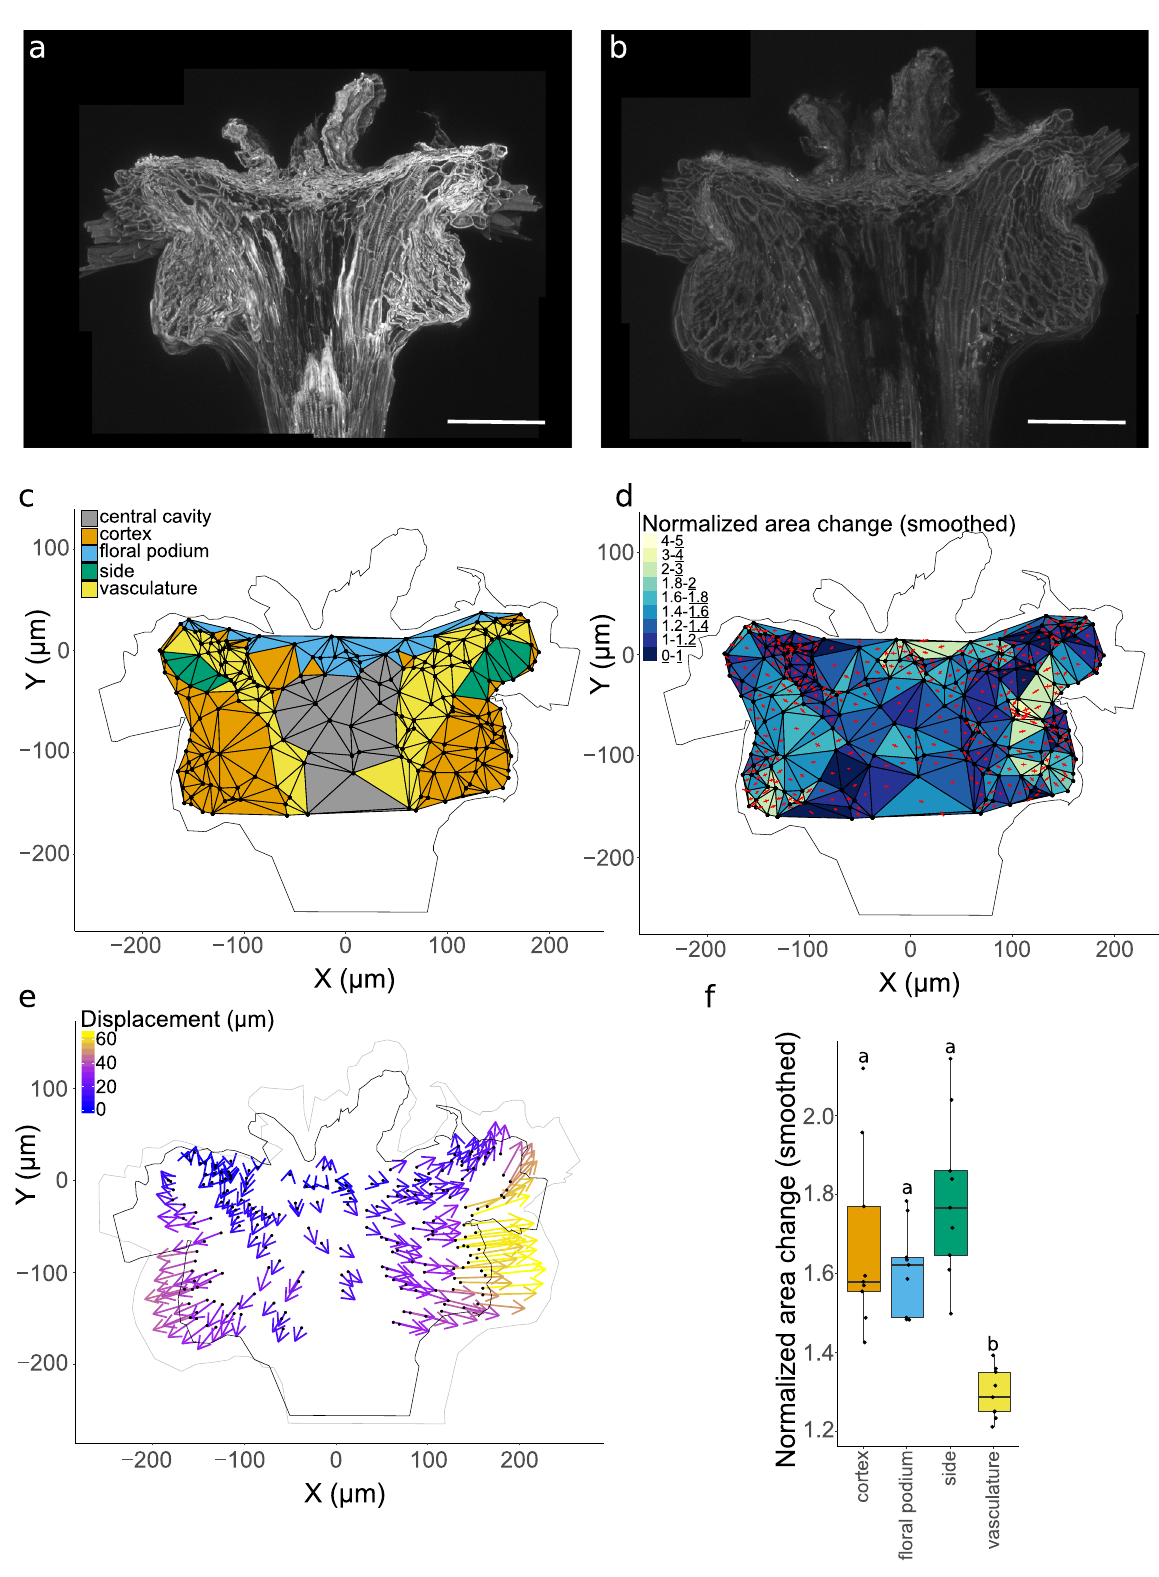
Fig. 4 Apical plate regional expansion and displacement. a , b Confocal images of apical plate auto fl uorescence in dry, a , and hydrated, b states, scale bars are 100 μ m, and images are representative of n = 9 biologically independent samples. c Landmarks and triangulation with regions annotated. d Smoothed change in area of each triangle (wet area/dry area). Red crosses indicate principal directions of expansion. e Displacement of landmarks relative to upper central part of the apical plate. f Change in area by region. ANOVA F (3,32) = 14.44, p <0.0001, η 2 = 0.58. Different letters above two boxplots indicate statistically signi fi cant differences between the two corresponding conditions with two-sided Tukey ’ s HSD at p <0.01. The centre line is the median, hinges indicate fi rst and third quartiles, and whiskers extend to largest value no further than 1.5 times the interquartile range. n = 9 biologically independent samples for all